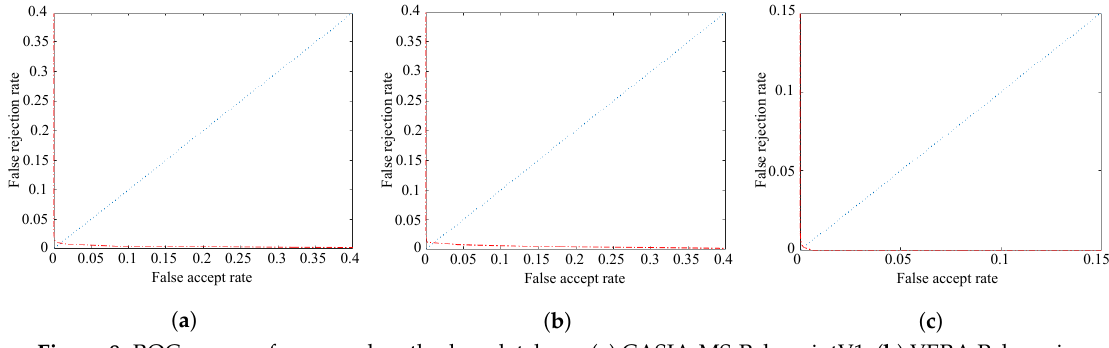
Figure 8. ROC curves of proposed method on database: ( a ) CASIA-MS-PalmprintV1; ( b ) VERA Palm vein; and ( c ) PUT Vein. Table 4. Results of the proposed method on the databases in verification